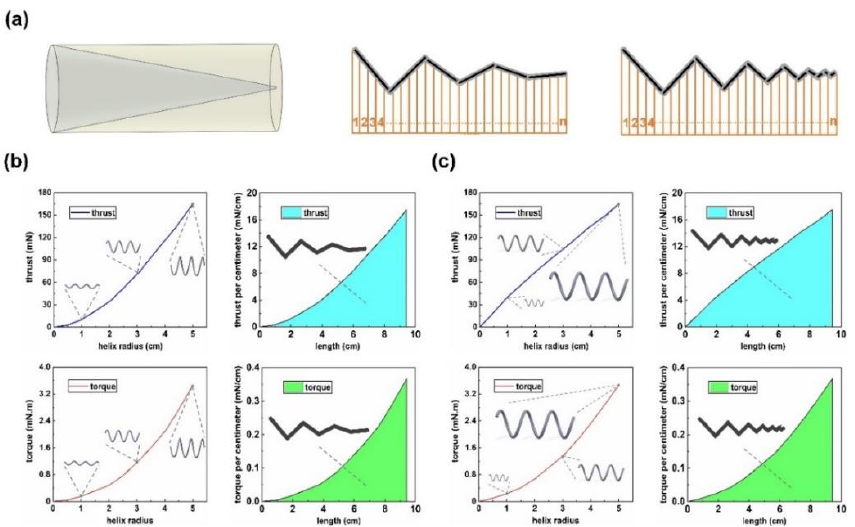
Figure 6. ( a ) On the left, it shows the enclosed volume of the two types of tapered helical swimmers (gray area) and the basic model (pale yellow area). On the right, it describes the calculation process of the two types of tapered helical swimmers. Both of them are divided into numerous micro-elements; The final thrust and torque are obtained by linear superposition of the micro-elements. The results of thrust and torque are in the blue and green area, respectively. ( b ) The tapered helical swimmer with a constant pitch is on the left; ( c ) The tapered helical swimmer with constant helix angle is on the right.